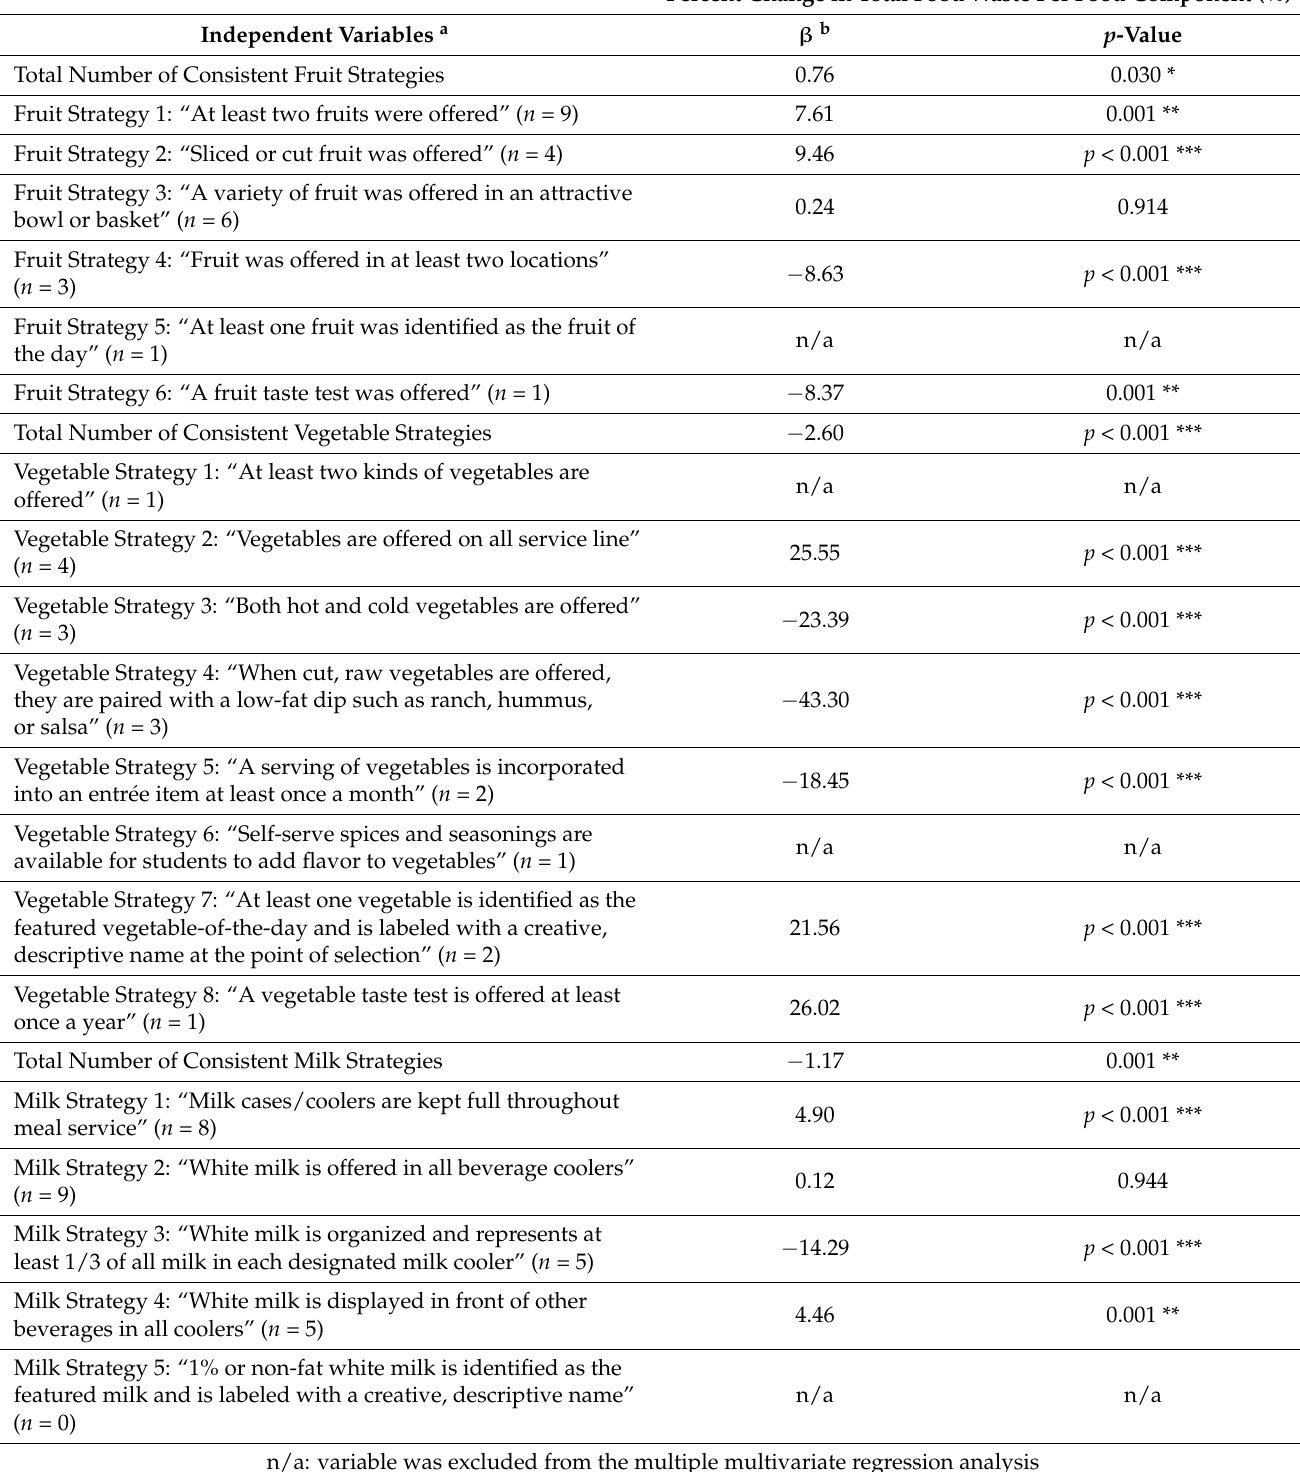
Table 4. Coefficient Estimates for Multiple Linear and Multivariate Regression Analyses Examining Associations between the Total Number and Type of Consistent Strategy Implemented with Percent Change in Total Food Waste per Food Component ( n =